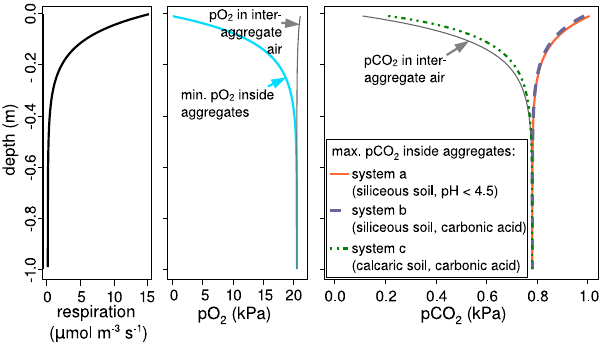
Fig.8. Modelled O 2 (middle)and CO 2 (right)partialpressures(0–1 m soildepth)intheinter-aggregate Fig. 8. Modelled O 2 (middle) and CO 2 (right) partial pressures (0– air andthemaximumvaluesin thewater phaseinside thesoilaggregatesforsiliceousandcalcaricsoil. Respiration(left)mainlytakesplaceintheupper30cmofthesoil. 1m soil depth) in the inter-aggregate air and the maximum values in the water phase inside the soil aggregates for siliceous and calcaric soil. Respiration (left) mainly takes place in the upper 30cm of the soil. 27